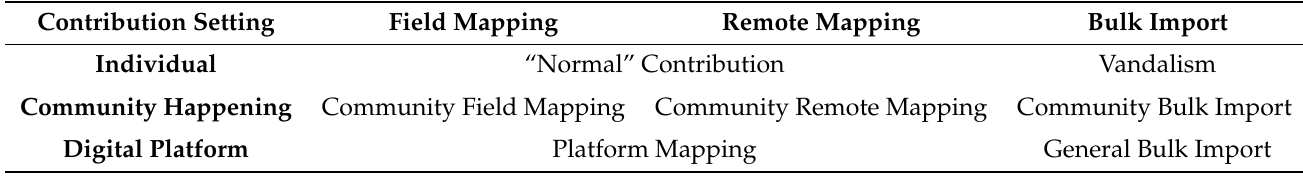
Table 1. Overview of different types of OpenStreetMap (OSM) contributions with respect to their contribution setting and data collection technique. The contribution setting describes the social circumstances of a contribution, i.e., the amount of (possible) direct social interaction. While an individually committed contribution is subject to no (direct) social constraints, a platform like the HOT Tasking Manager offers the possibility for exchange in chats and online discussions. A bulk import committed by a individual mapper is seen as vandalism according to the rules set by the OSM community lacking substantial community buy-in